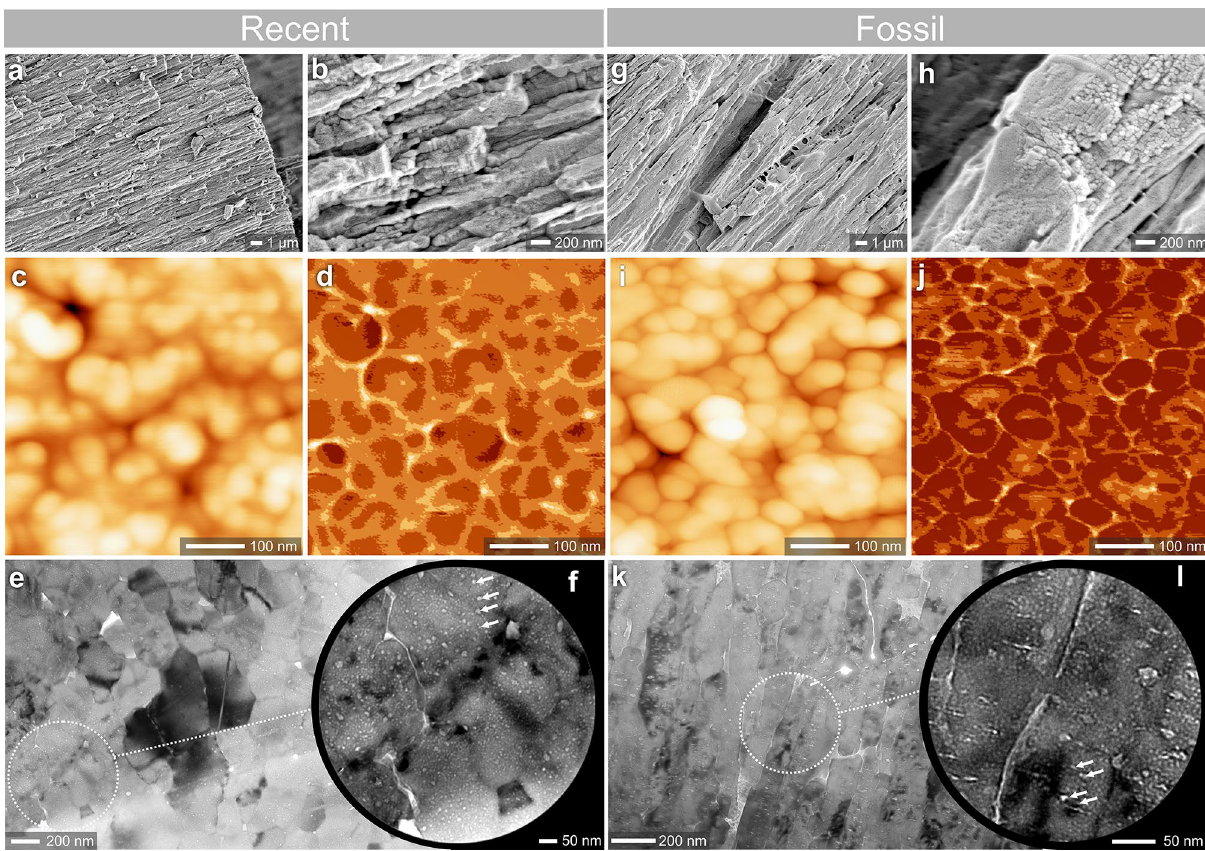
Figure 2. Composite, organic-mineral structure of Phycis phycis ( a–f ) and fossil Phycis tenuis ( g–l ) saggital otoliths. In FESEM the aragonite fibers of modern and fossil otoliths consist of slender units ca. 200–300 nm wide ( a,g ) that in higher magnification ( b,h ) show nanogranular organization; nanograins ca. 50–100 nm in diameter are visible in AFM height-mode ( c,i ) and peak force error-mode ( d,j ) images. TEM observations of skeletal lamellae (extracted by focused ion beam) show aragonite, fine-scale fibers (comparable in size with those observed in FESEM) that include numerous organic inclusions (arrows in f,l ). Fibers in ( e ) cut obliquely or longitudinally ( k ) to the growth direction. ZPAL P.21/R-OTH-187/002 ( a–f ); ZPAL P.21/C-OTH-07/007 ( g–l ).